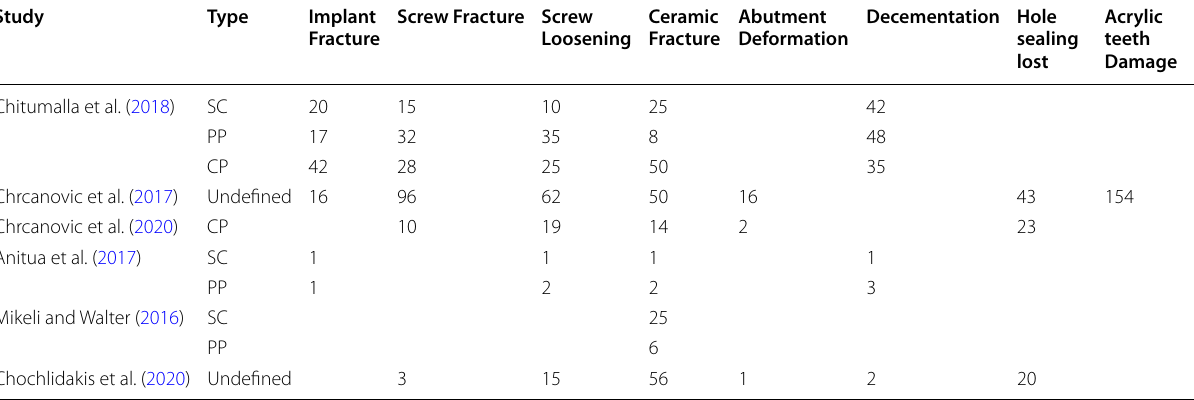
The numbers in this table represent prosthesis number and not the number of complications SC single crowns, PP partial prosthesis, CP Complete